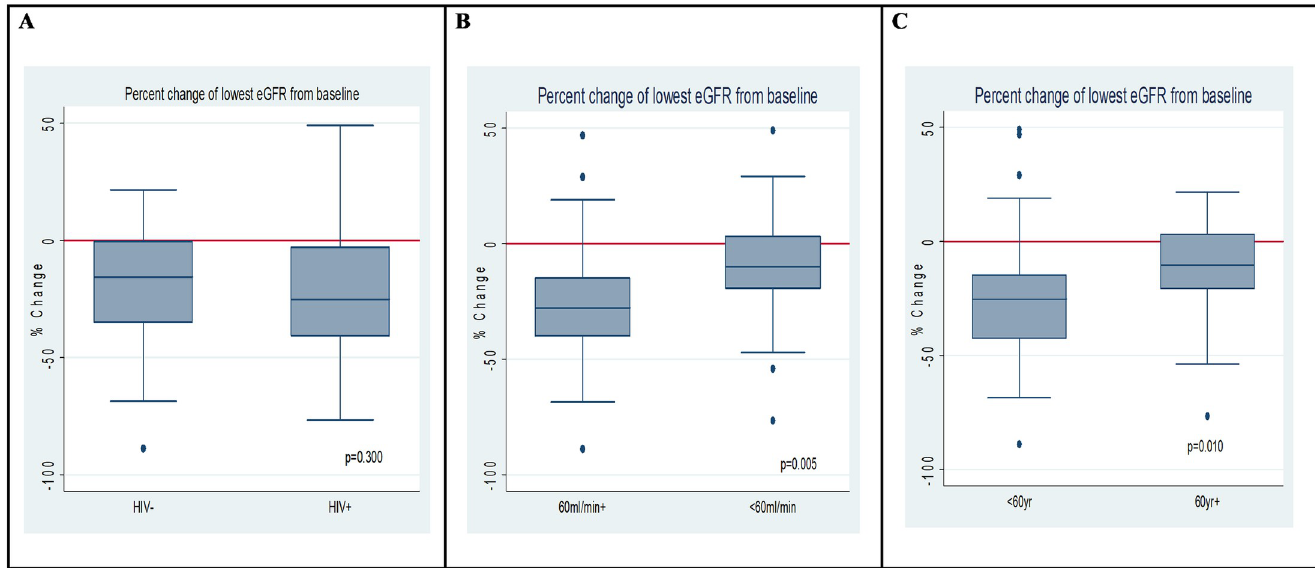
Fig 1. Boxplot of percentage difference in baseline eGFR and lowest eGFR during cisplatin treatment according to A) HIV status B) Baseline eGFR < and � 60ml/min C) Age < and � 60 years of age.